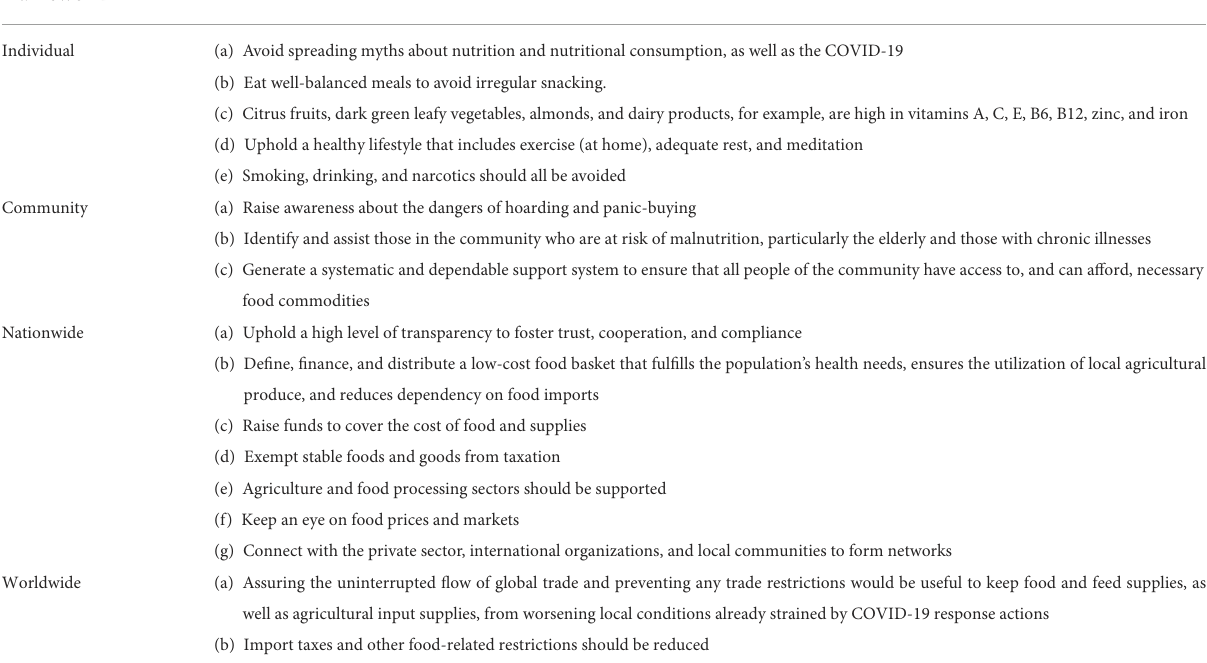
TABLE 5 Recommendations to reduce COVID-19’s impact on nutrition and food security.